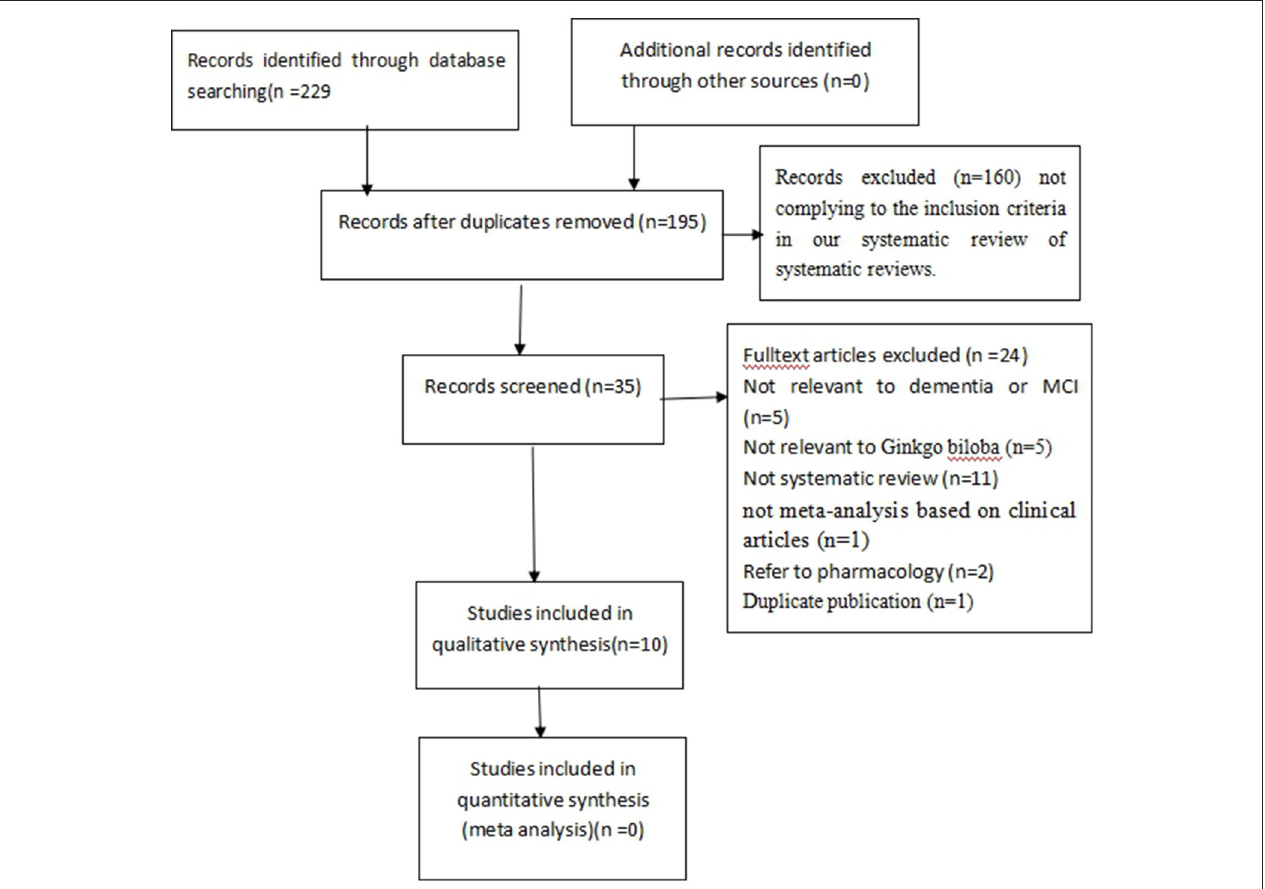
FIGURE 1 | Flow Diagram of included systematic